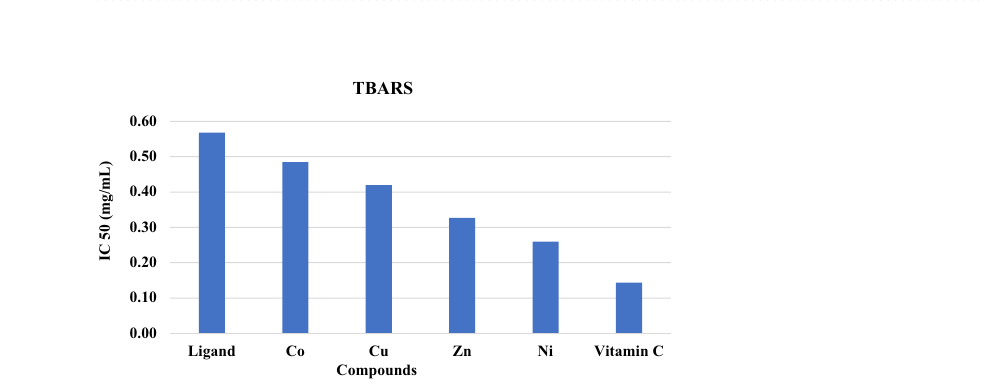
Table 5. The effect of ligand and its complexes on antioxidant reducing power at different concentrations (0.05–0. 5 mg/mL).